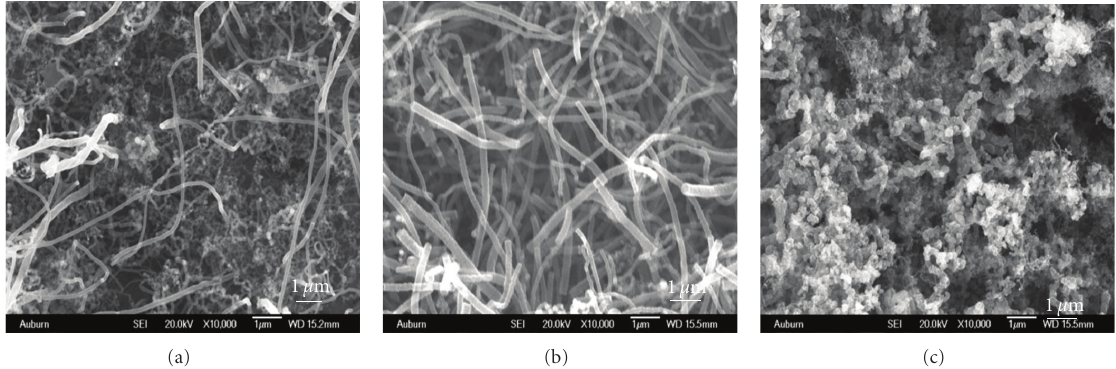
Figure 9: Synthesized CNF for e ff ect of synthesis temperature on 815 ◦ C faceted foil. Temperature: (a) 520 ◦ C, (b) 570 ◦ C, and (c) 620 ◦ C. Synthesis gas: 2% C 2 H 2 , 20% NH 3, and 78% H 2 (Table 1 (Phase